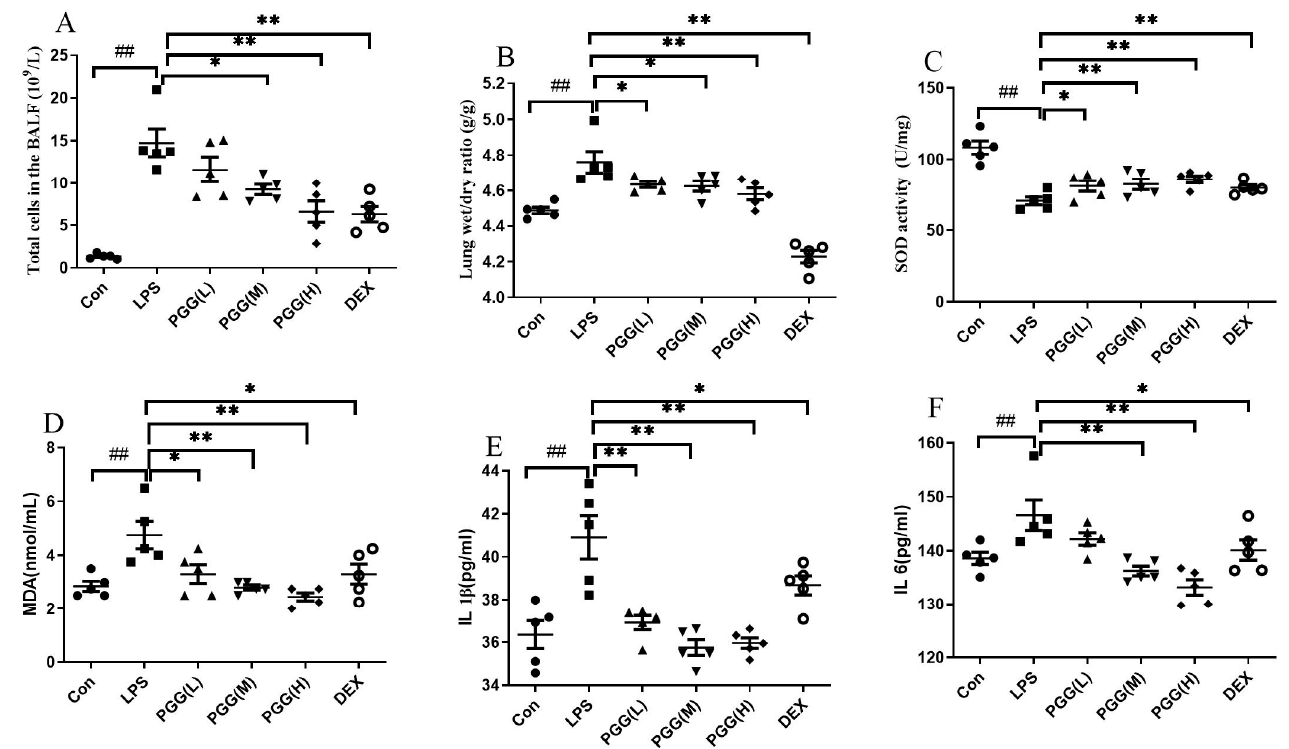
Figure 1. Effects of PGG on anti-inflammatory and antioxidative indicators in ALI rats. DEX and PGG were administered intraperitoneally for three days, and the ALI model was established 1 h after the last administration; animals were sacrificed 12 h later. ( A ) Total leukocyte counts in the BALF; ( B ) lung W/D ratio; ( C ) value of MDA in BALF; ( D ) value of SOD in BALF; ( E ) the IL-1 β level in BALF; ( F ) the IL-6 level in BALF. Values are indicated as the mean ± standard deviation (SD). ## p < 0.01 vs. Con group; * p < 0.05, ** p < 0.01 vs. LPS group. ALI, acute lung injury; BALF, bronchoalveolar lavage fluid; Con, control group; DEX, dexamethasone; LPS, lipopolysaccharide; MDA, malondialdehyde; PGG, 1,2,3,4,6-O-pentagalloylglucose; PGG (LD), PGG (15 mg/kg) + LPS group; PGG (MD), PGG (30 mg/kg) + LPS group; PGG (HD), PGG (60 mg/kg) + LPS group; SOD, superoxide dismutase; W/D, wet/dry.